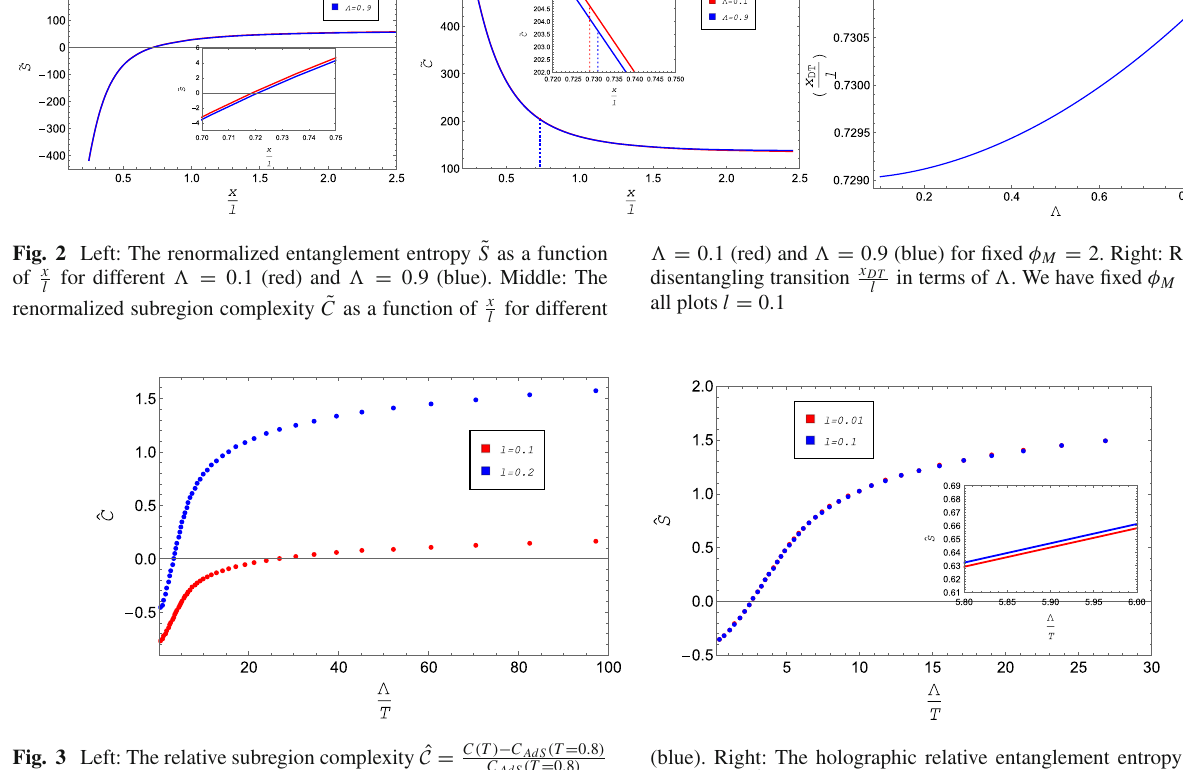
(blue). Right: The holographic relative entanglement entropy ˆ S as a C AdS ( T = 0 . 8 ) for different l = 0 . 01 (red) and l = 0 . 1 (blue). we have function of (cid:3) T fixed (cid:3) = 0 . 8 and φ M =